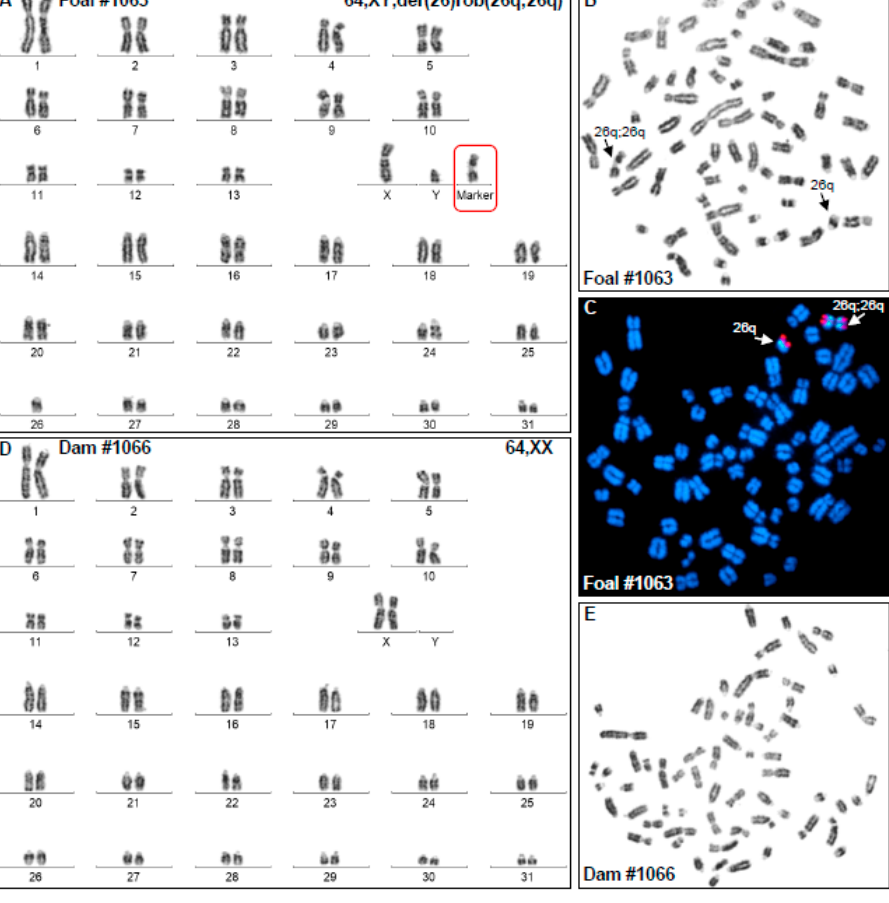
Figure 1. Cytogenetic analysis results. ( A ) GTG-banded karyotype of the affected foal H1063 showing 64,XY karyotype with a single ECA26 and a metacentric derivative chromosome with the arms corresponding to ECA26q; ( B ) Metaphase spread corresponding to H1063 karyotype; arrows show the normal and derivative ECA26; ( C ) FISH results with ECA26 BAC clones (BAC 9N4 green; BAC 91H11 red) showing (arrows) the presence of a single ECA26 and a metacentric derivative chromo- some 26q;26q; ( D ) GTG-banded karyotype of the dam (H1066) showing normal 64,XX female kary- otype; ( E ) Metaphase spread corresponding to the karyotype of the dam (H1066).